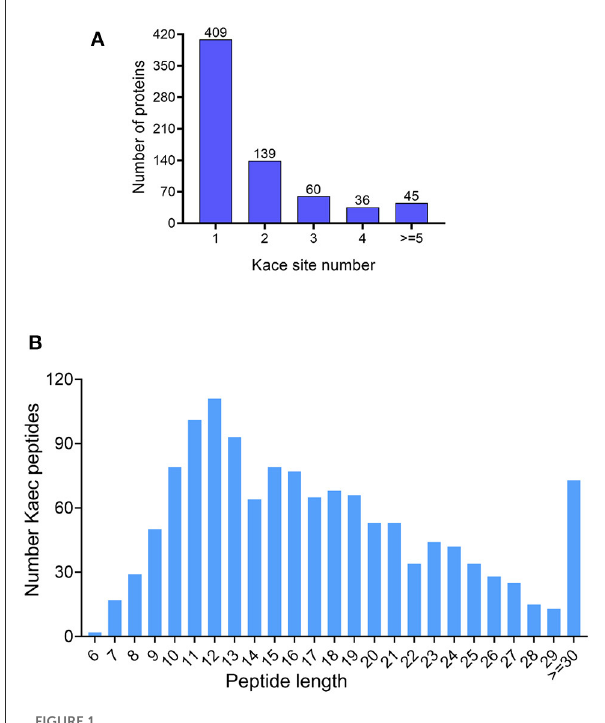
FIGURE1 Outline of acetylome under bile salt stress in V. alginolyticus . (A) Site coverage of acetylated proteins, and (B) Distribution of acetylated peptide